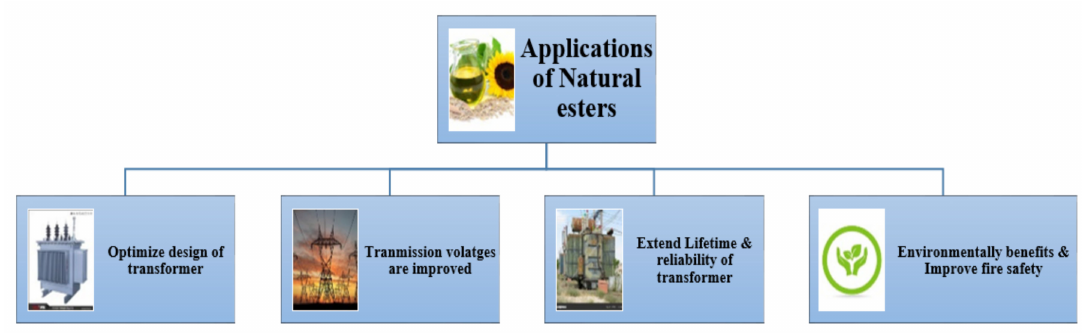
Figure 7. Overview of gains achieved by the application of natural esters as a substitute of